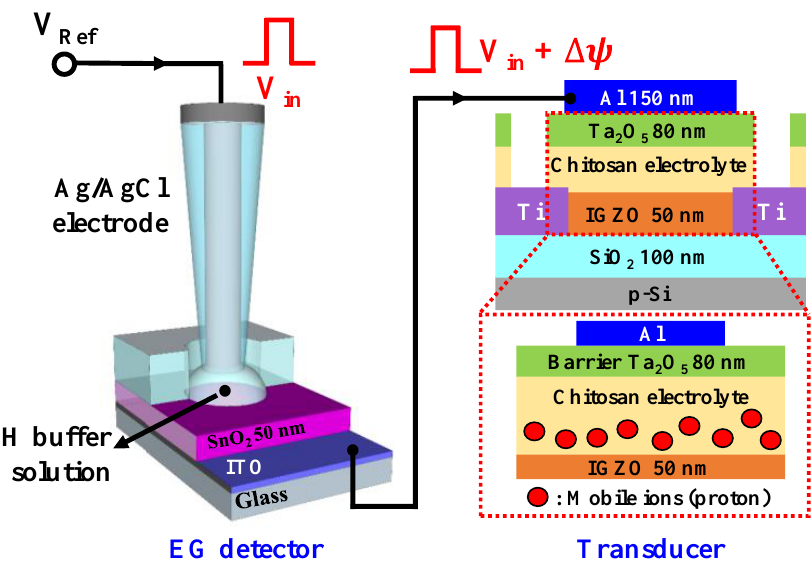
Figure 4. Schematic of a time-dependent pH sensor configured with a tunable chitosan/Ta 2 O 5 hybrid dielectric EDLT and an EG.